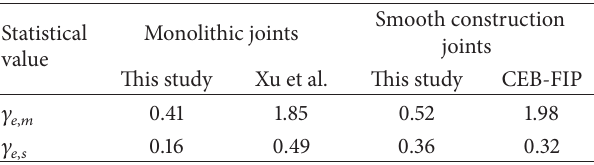
Table 2: Comparisons of normalized root mean square error obtained from each shear stress-relative slip